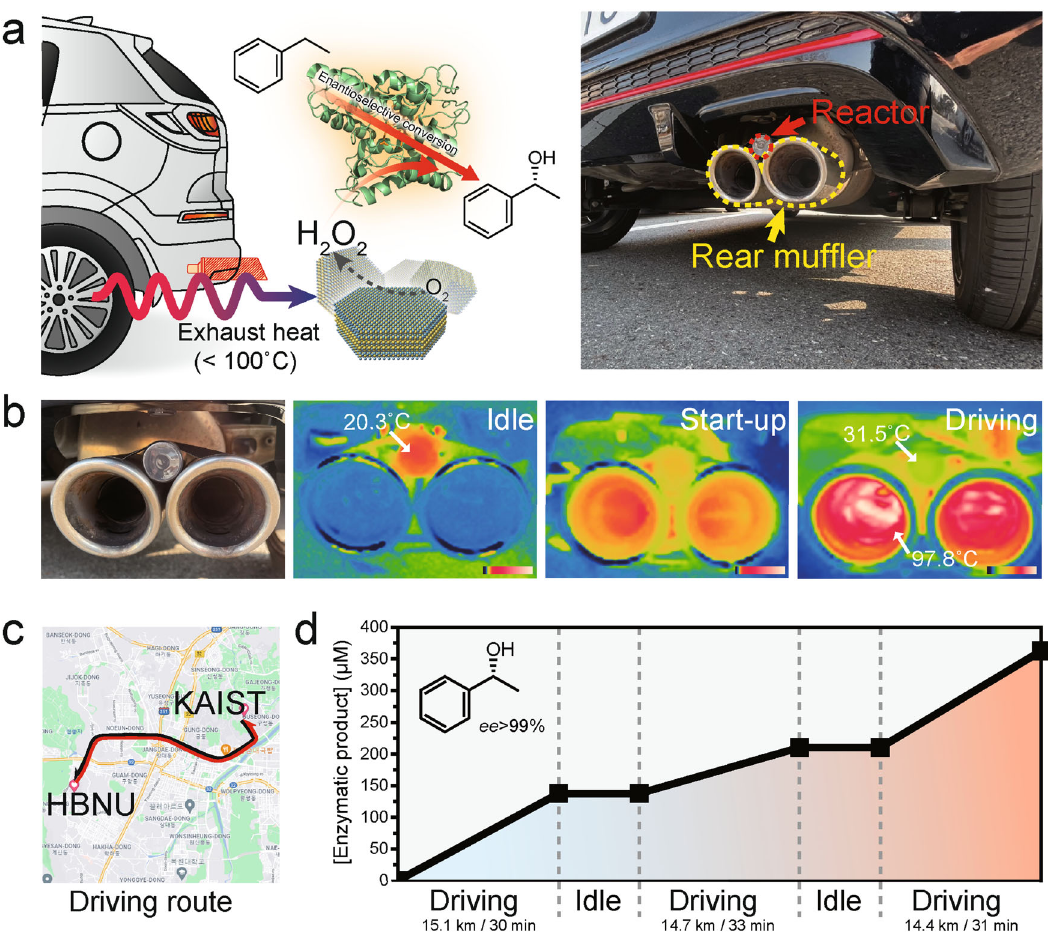
Fig. 6 Waste heat mining for fi ne chemical synthesis during urban driving. a A scheme and a digital photograph of the practical application of TEBC for vehicle exhaust-heat recovery system. A glass reactor was attached on the rear muf fl er of the vehicle. b Digital photographs of the vehicle rear muf fl er before and after driving, which was recorded by thermal imaging infrared camera. Color bars denote the measured temperature from 0 to 100 °C on a linear scale. c Selected driving route between Korea Advanced Institute of Science and Technology (KAIST) and Hanbat National University (HBNU). Map data: ©2022 Google, TMAP Mobility. d Generation of enantiopure ( R )-1-phenylethanol using the exhaust-heat-fueled Bi 2 Te 3 /UPO system during